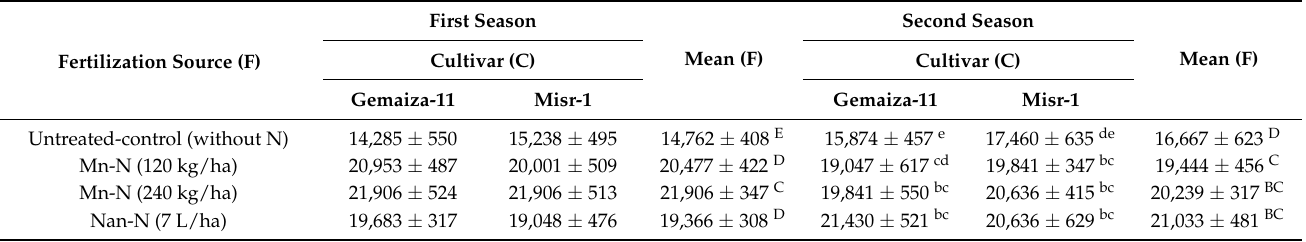
Table 10. Impact of nano- and mineral nitrogen fertilizers on the biological yield (kg/ha) of two wheat cultivars during the 2019/2020 and 2020/2021